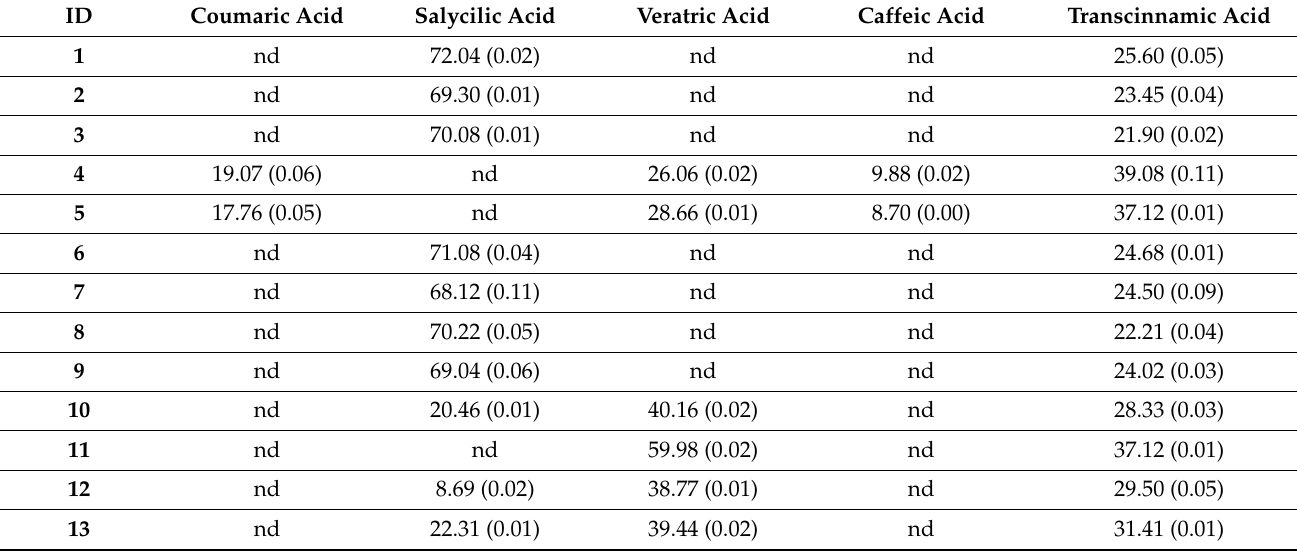
Figure 3. Total relative percentages of phenolic acids and fatty acids. Table 4. Relative content of phenolic compounds in S. patula samples. nd: not detected.